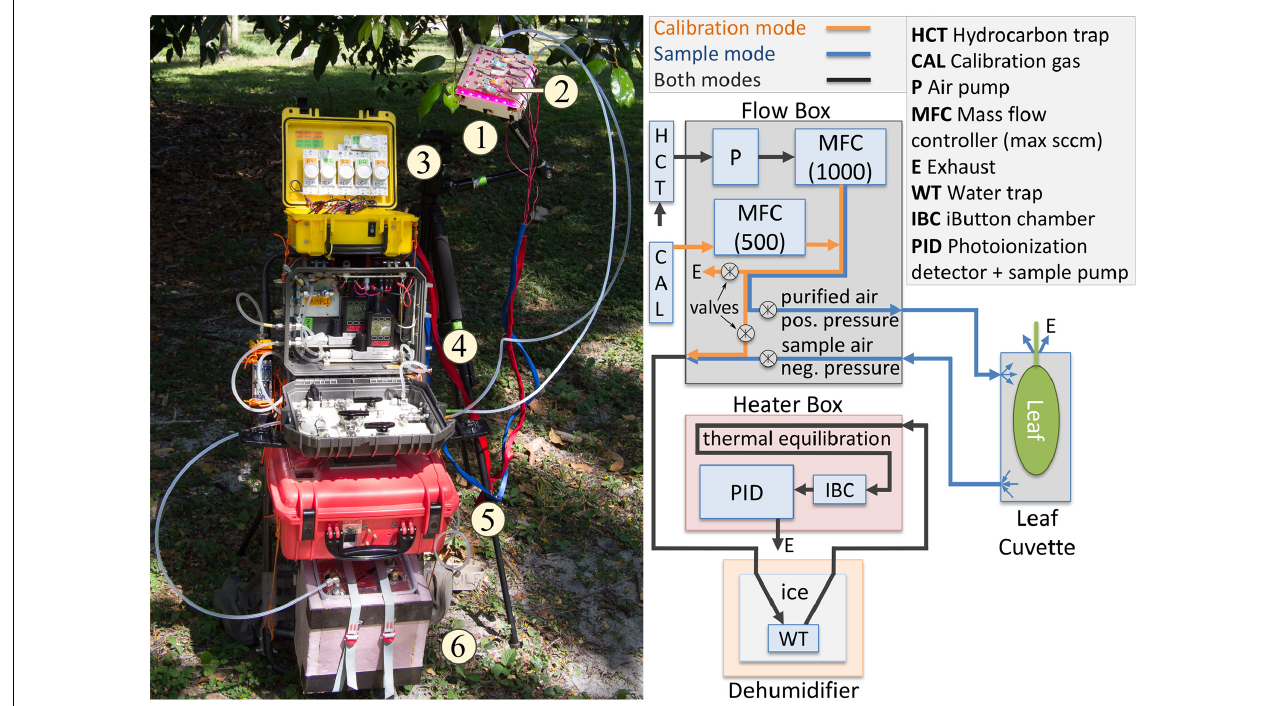
FIGURE 1 | Overview of PORCO components and flow paths. (1) Several acrylic leaf cuvettes accommodate different leaf shapes and sizes. (2) Light emitting diode (LED) panels produce photosynthetically active light. (3) Photon flux density at the leaf is regulated by electrical current control to the light panels. (4) A Flow Box regulates air flow rates and pathways for calibration and sampling via a pump, mass-flow controllers, valve manifold, hydrocarbon trap, and calibration gas. The hydrocarbon trap purifies ambient air for use in calibration and flow-through sampling. (5) Enclosed in a temperature-controlled case, a photoionization detector (PID) with an internal air pump draws sample air from the cuvette. (6) Humidity of calibration air or sample air returning from the leaf cuvette is kept constant by conditioning through chilled tubing in ice and water. The heater, Flow Box, and light control system are each powered by independent lithium ion batteries. The PID contains its own lithium ion battery that powers its internal pump, computer, and sensor components. The PID displays live measurement data, viewable through the enclosure window, in the form of an uncalibrated numerical reading that varies at 1 Hz as it is recorded to the datalog. Data post-processing is performed by custom software in